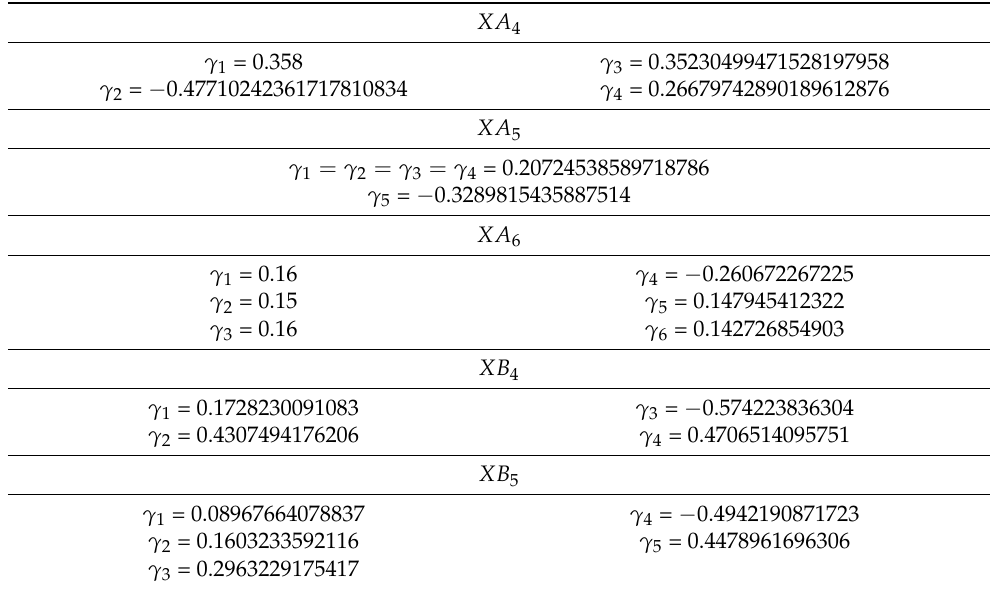
Table 2. Coefficients for composition schemes of fourth order with different number of